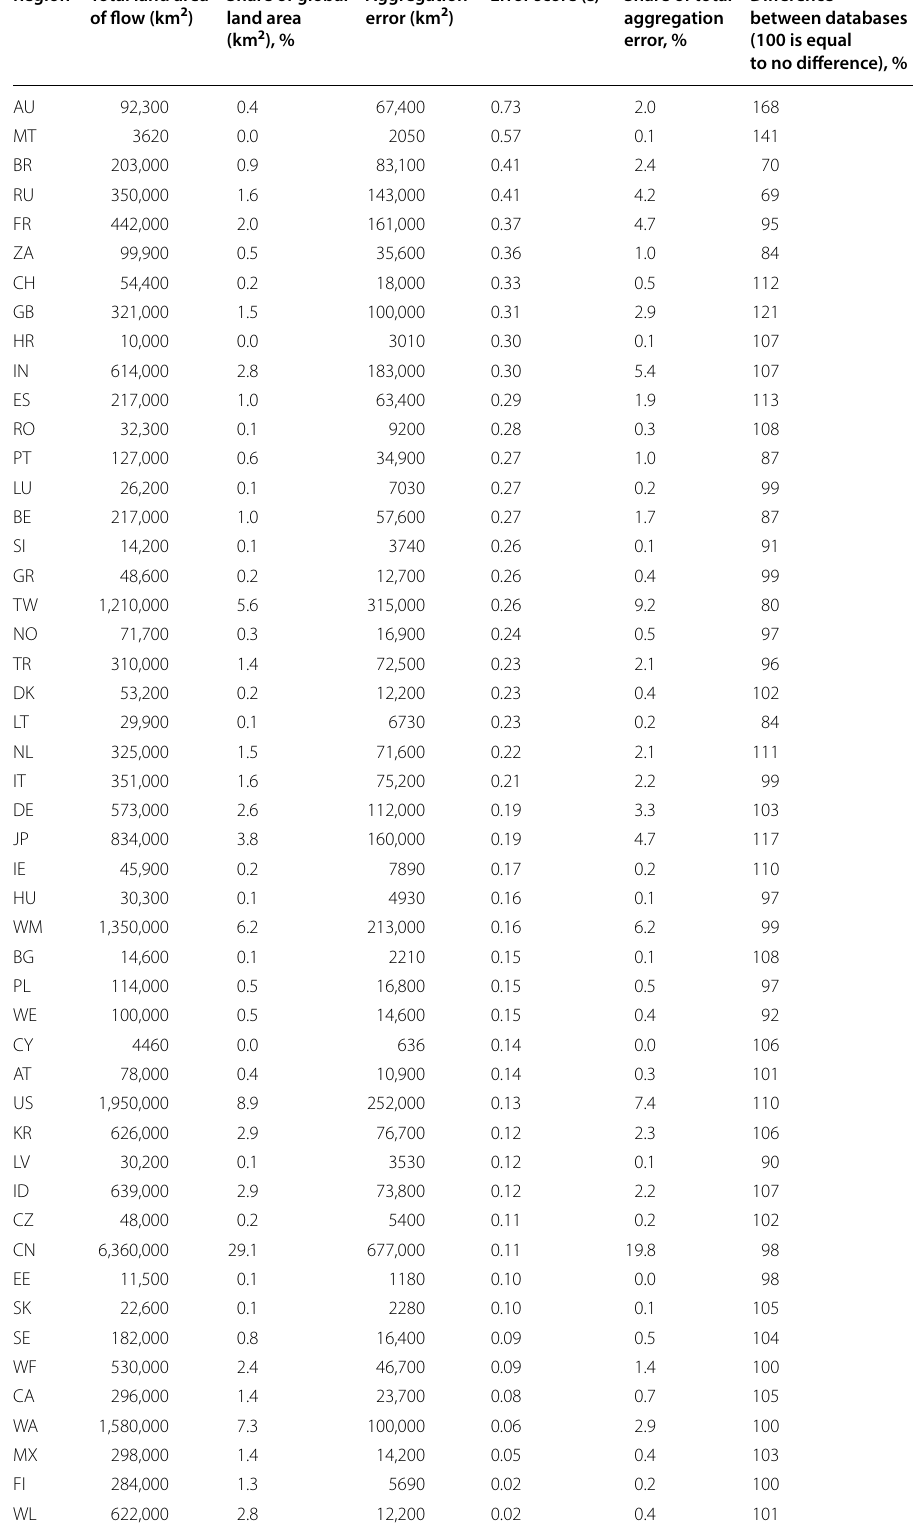
Table 4 Land embodied in imports and aggregation error of 49 regions (2015) Region Total land area of flow (km 2